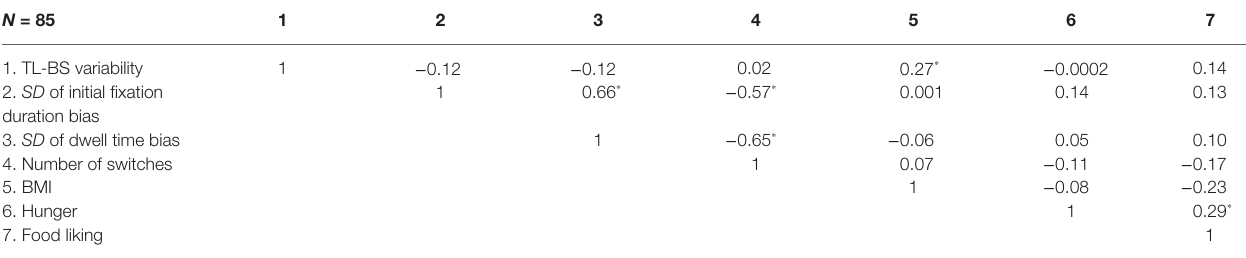
TABLE 5 | Correlations between BMI, hunger level, food liking, and attentional bias fluctuation indexes. N = 85